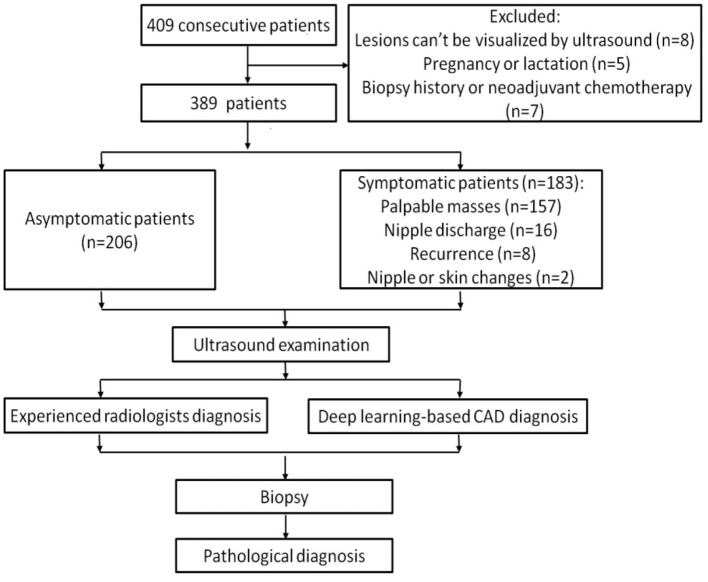
The flow diagram of the study.